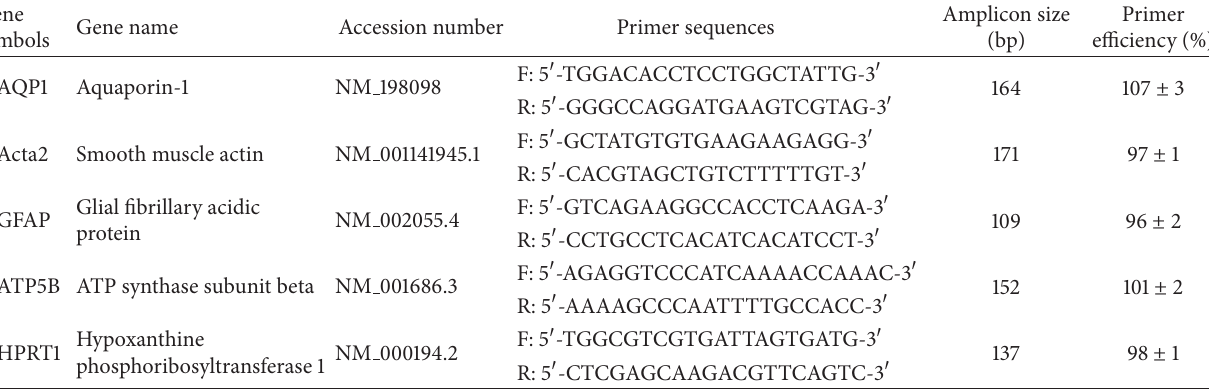
Table 2: Gene symbols, gene name, accession number, primers sequences, amplicon sizes, and primer efficiencies of the tested genes (mean ± S.E.M., 𝑛 = 3 ).